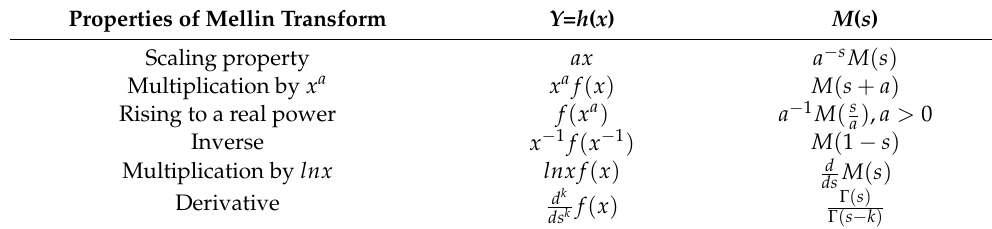
Table 1. The properties of the Mellin transform. Properties of Mellin Transform